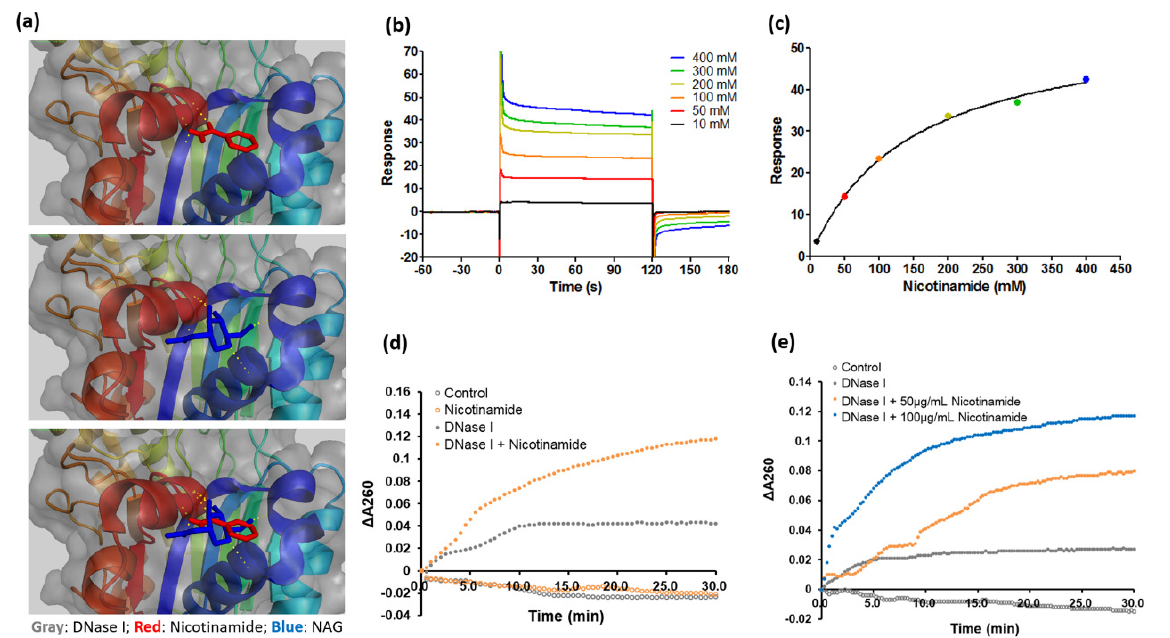
Figure 6. Binding of nicotinamide (NAM) to deoxyribonuclease (DNase) I increases the activity of the enzyme. ( a ) The binding site of NAM (red) and the glycosylation site of N-acetylglucosamine (NAG, blue) on DNase I (gray) are shown by model-assisted computational molecular docking. ( b ) The association and dissociation between NAM and DNase I are shown by surface plasmon resonance. The process was expressed as the differential response unit between the binding of NAM to the DNase I–immobilized sensor chip or to a blank sensor chip. ( c ) The equilibrium-state response unit recorded by surface plasmon resonance is plotted versus the concentration of NAM. The apparent equilibrium dissociation constant is 0.1424 M. ( d , e ) The activity of DNase I was measured by a kinetic ELISA, with DNA as substrates. The breakdown of DNA was detected by the absorbance at 260 nm (A260). The slope of the initial curve corresponds to the reaction rate of DNase I. ( d ) Kinetic ELISA showing the effect of NAM on the activity of DNase I. ( e ) Kinetic ELISA depicting the activity of DNase I at indicated dosages of NAM.